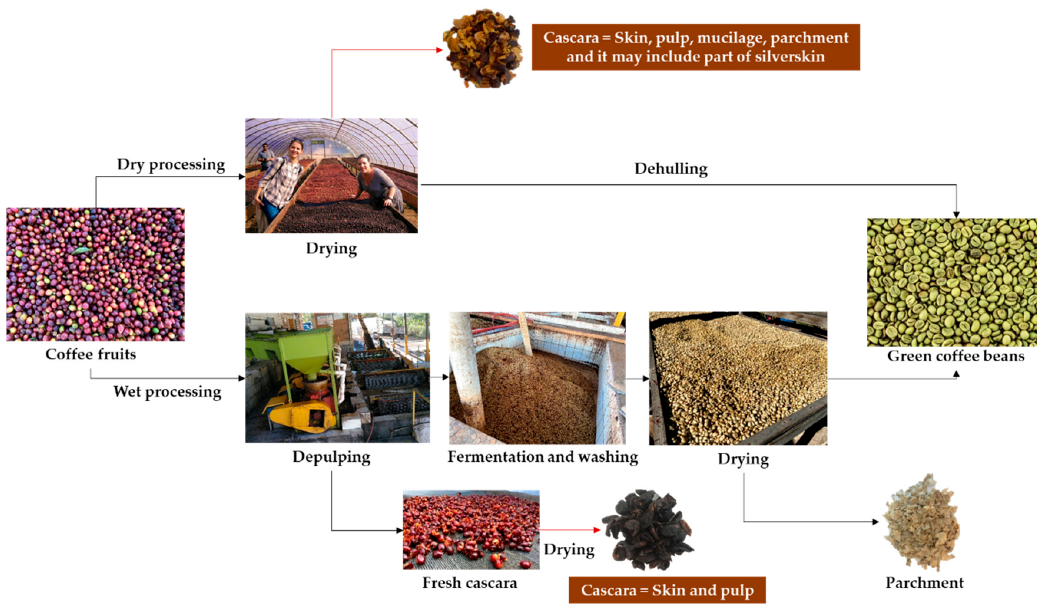
Figure 2. Dry ( top ) and wet ( bottom ) processing of coffee cherries. Photographs were taken in Combrifol and Café Orgánico Marcala S.A. (COMSA), Marcala, Honduras.